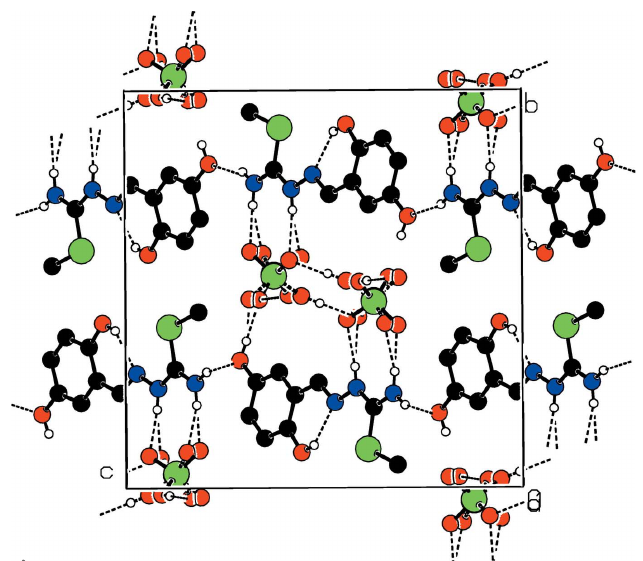
Figure 2 Projection along the a axis of the crystal packing of the title molecular salt. Hydrogen bonds are shown as dashed